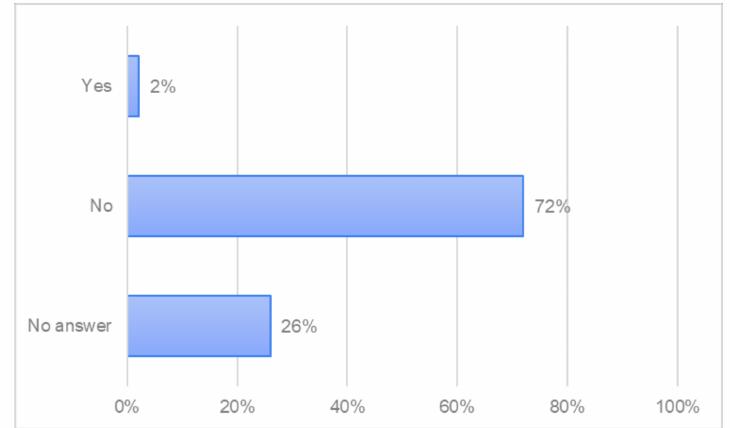
Figure 4. Summary of injuries at the accidental cutting of safety rope or stem-loop.